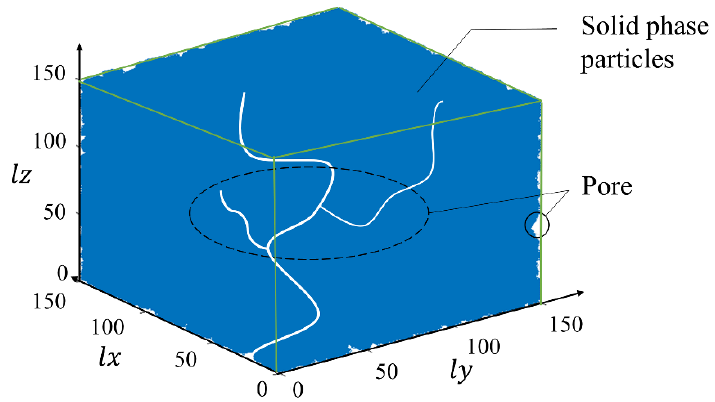
Figure 3. Scatter plot of pore model.